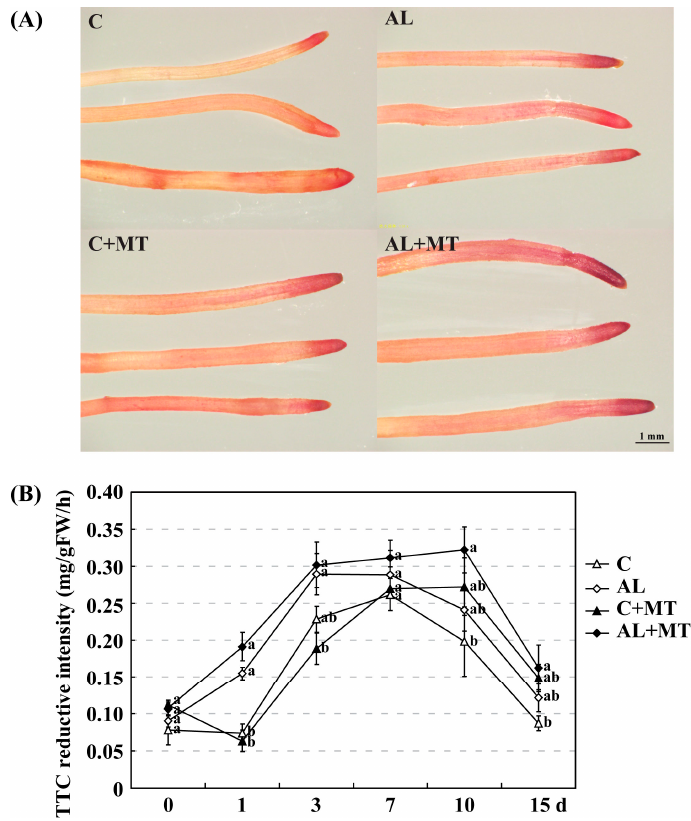
Figure 4. Changes in root activity for Malus hupehensis Rehd. seedlings exposed to alkaline stress, with or without melatonin treatment. ( A ) Absorbing roots were stained with triphenyl tetrazolium chloride (TTC) at the end of the treatment period. ( B ) TTC reductive intensity detected in roots. Lower-case letters indicate significant differences among treatments, based on Duncan’s multiple range test ( p < 0.05).